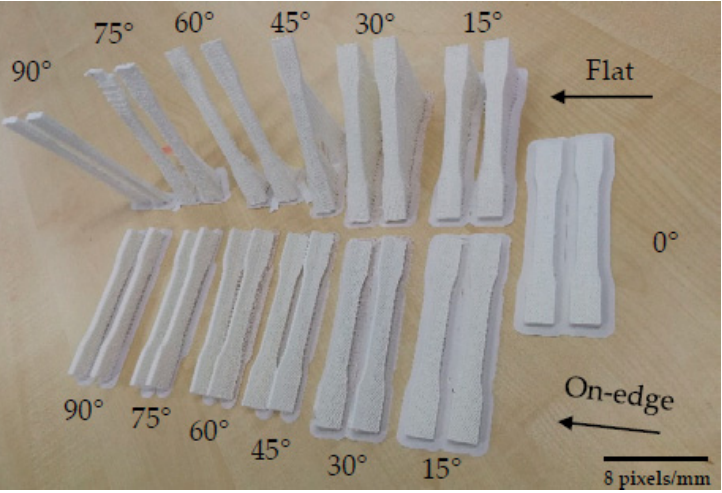
Figure 23. Three-dimensional printed PLA samples with different build orientations [160]. They also analyzed the strength of different infill patterns (such as honeycomb, rec- tilinear, lattice, cubic, Hilbert curve, and others) using finite element analysis (FEA). The specimens printed at the edge had better mechanical properties compared to the flat spec- imens. In both directions, the 0° specimen had the highest strength (Figure 24) and the best quality compared to the vertical and perpendicular specimens.